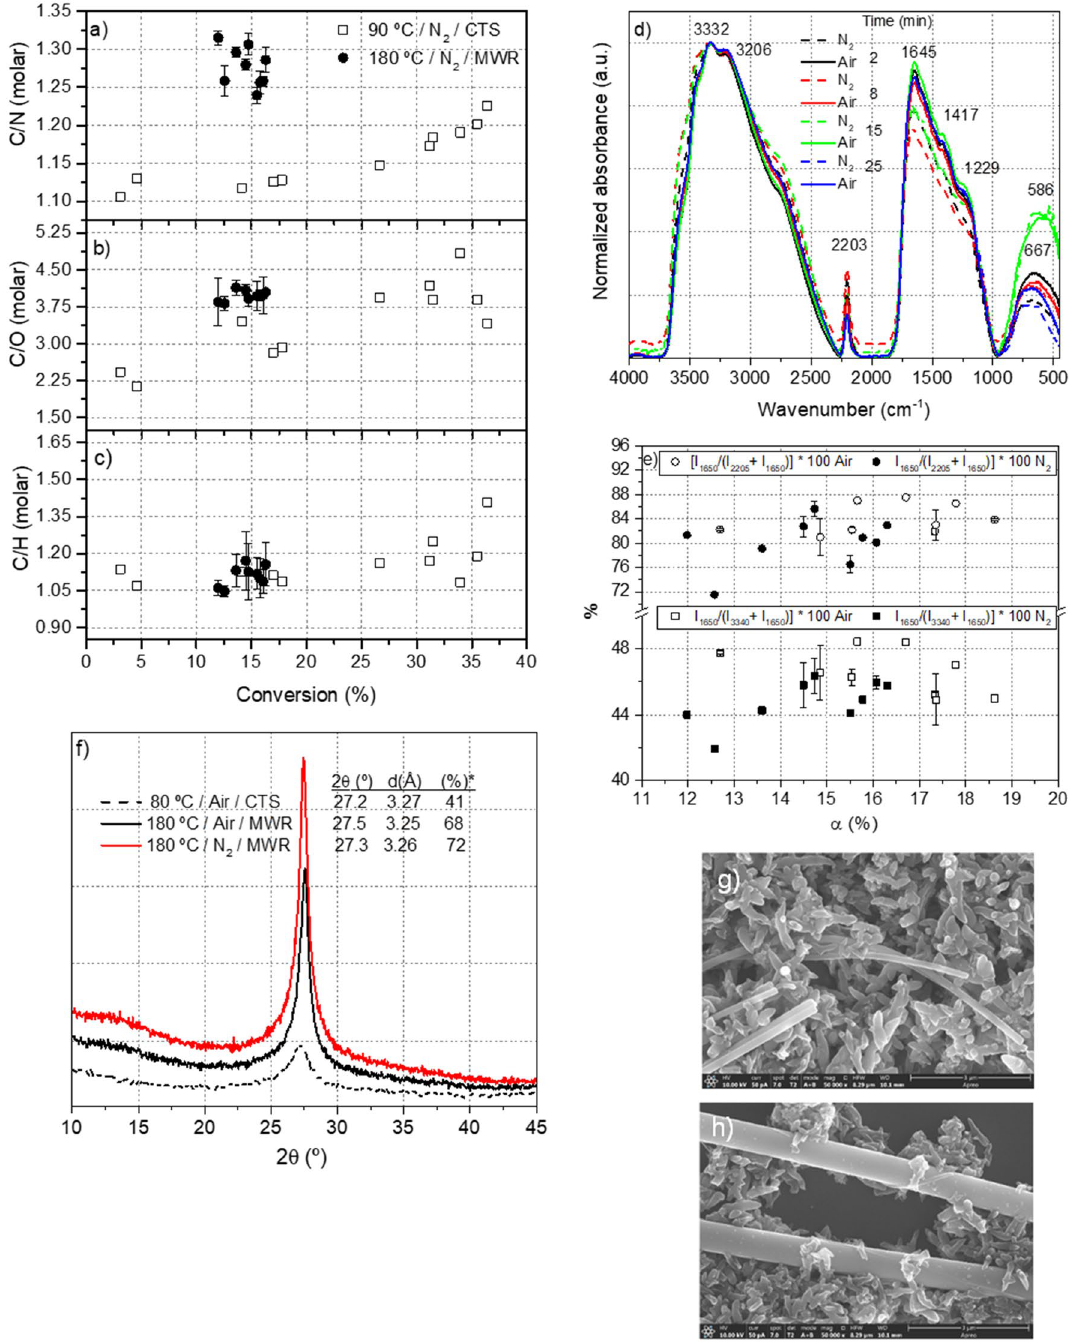
Figure 2. ( a ), ( b ) and ( c ) Molar relationships for insoluble NH 4 CN polymers, gel fractions, synthetized at 90 °C using a conventional thermal system (CTS) and at 180 °C via microwave radiation (MWR). Note that the values of C/H and C/N shown in Fig. 9 of Fernández et al. 2018 12 correspond to relationships in weight; no molar relationships like those represented here. ( d ) Representative FT-IR spectra of insoluble NH 4 CN polymers (gel fractions) obtained using microwave-assisted syntheses at 180 °C. ( e ) Dependence of both the extension of reaction ( EOR ) and the extension of conjugation ( EOC ) relationships on the reaction time calculated from the FT-IR spectra. For each point represented, at least two spectra were recorded, which were obtained from independent samples. ( f ) XRD patterns of representative samples. The X-ray diffractogram of the sample synthetized at 80 °C using CTS is shown with a comparative propose (Ruiz-Bermejo et al. 2019 10 ).* % of crystallinity of the sample. ( g ) and ( h ) SEM images of a representative